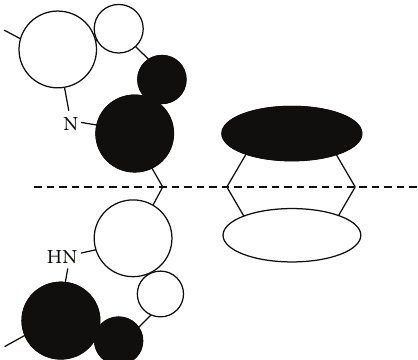
F 4: A possible through space interaction between the por- orbital and one of the e phyrin a u 1